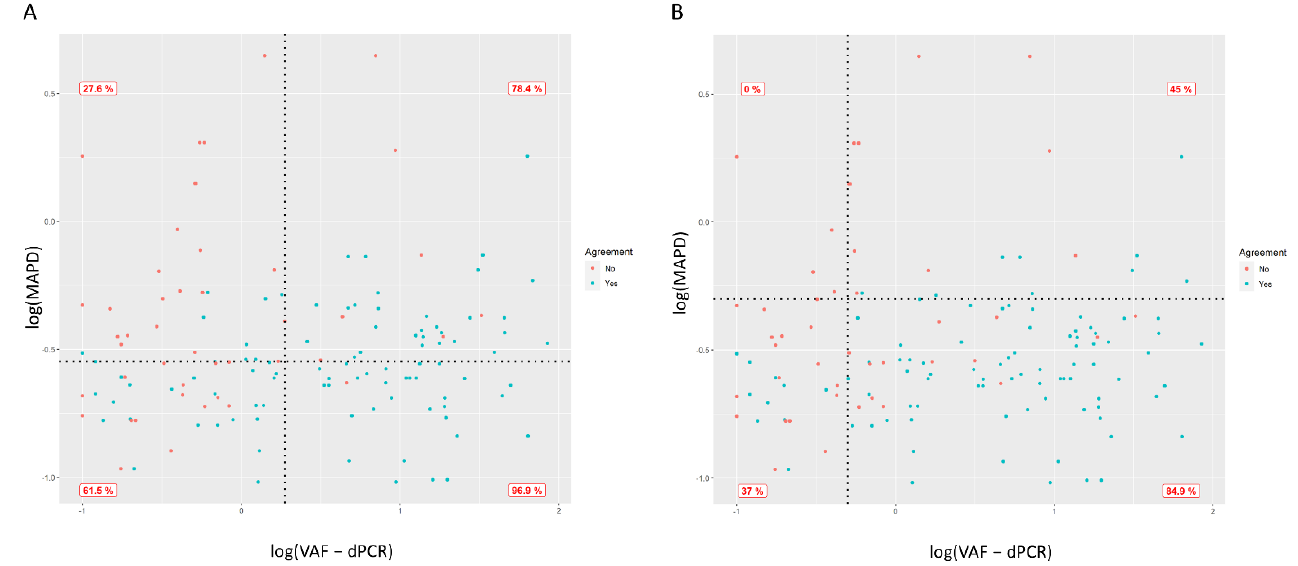
Figure 2. Dot plot showing the agreement in variant calls between dPCR—NGS-Oncomine, according to VAF and MAPD. VAF and MAPD values, both in logarithmic scale, are represented in the x and y -axis, respectively. Concordant calls are coloured in blue, while discordant calls are coloured in red. PPA for calls clustered in each quadrant is shown. ( A ) Dot plot divided into four quadrants using as cut-off the logarithmic median values of VAF and MAPD. In this way, the median VAF in our data set was 1.87, which is 0.272 on logarithmic scale, and the median MAPD was 0.28, which corresponds to − 0.553 on logarithmic scale. ( B ) Dot plot divided into four quadrants according to technical specifications. MAPD threshold was selected following Ion Reporter recommendations [17]. According to the manufacturer, a value of MAPD above 0.5 is considered too high. Samples with high MAPD values have low coverage uniformity, which can result in missed or erroneous variant calls. The VAF threshold was chosen based on results from previous studies [18]. Therefore, both axes were divided using − 0.301 value for VAF and MAPD (log(0.5)).